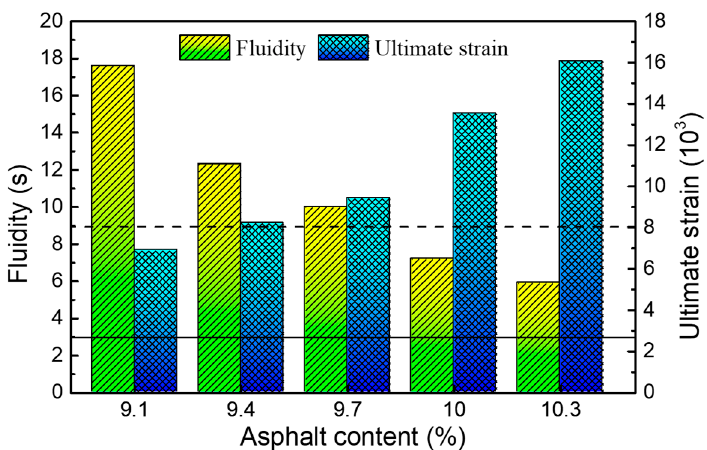
Figure 6. Influence of asphalt content on fluidity and ultimate strain. Note: fluidity value above the solid line, ultimate strain value above the dash line meets the requirements.